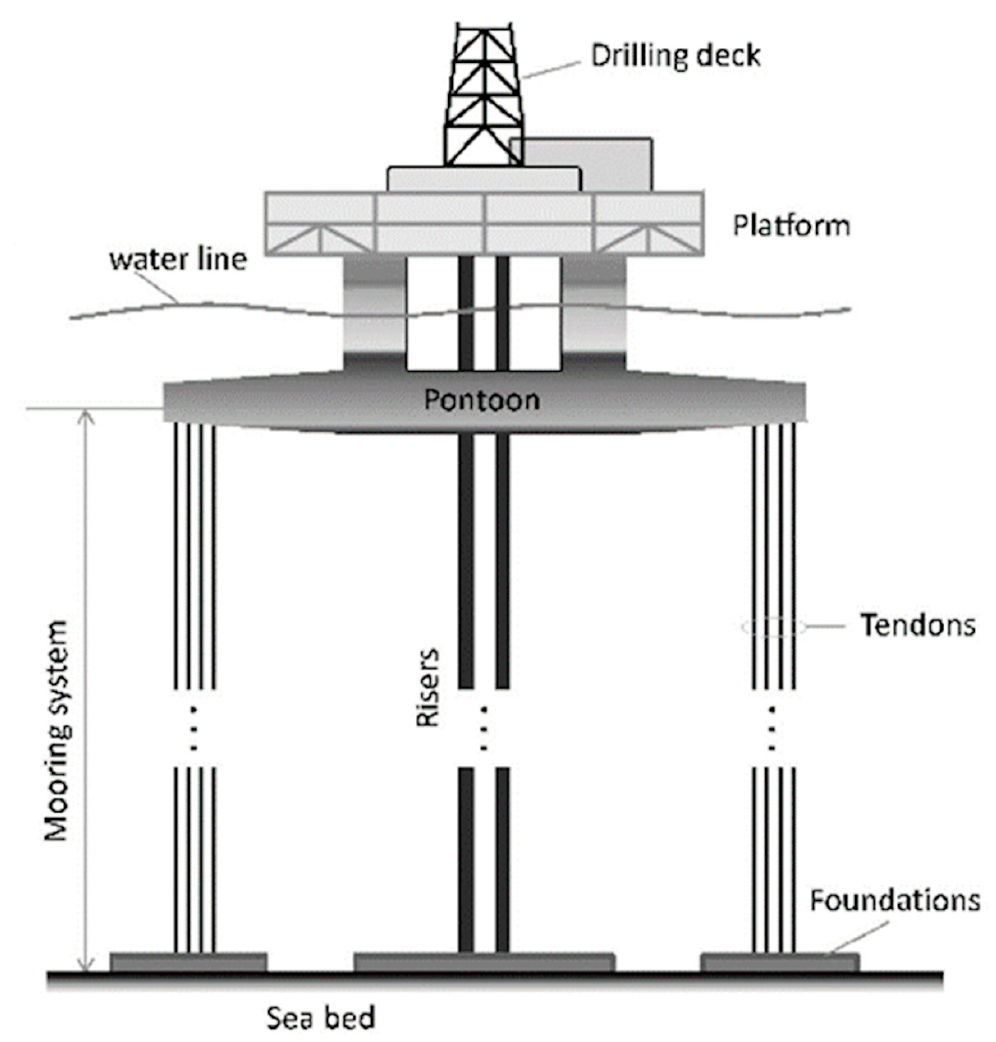
Figure 3. Schematic diagram of the tension leg platform (TLP) [29].